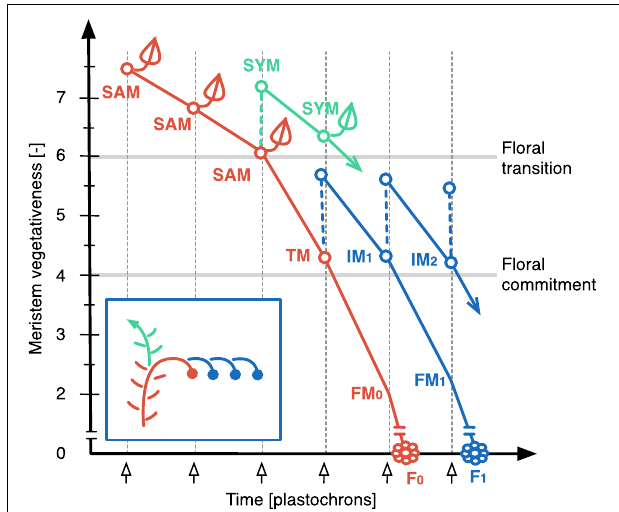
FIGURE 3 | The zigzag model. Plots show vegetativeness decline of successive meristems initiated at one-plastochron intervals. Colors represent different types of meristems (red: shoot apical meristem, SAM, called transitional meristem, TM, after floral transition; green: sympodial meristem, SYM; blue: inflorescence meristem, IM). TM and IM maturate toward floral meristem (FM) fate and become flowers (F). See Figure 1 for spatial visualization. Note that the vegetativeness level of the SYM should be higher than shown, since it usually produces more than one leaf.